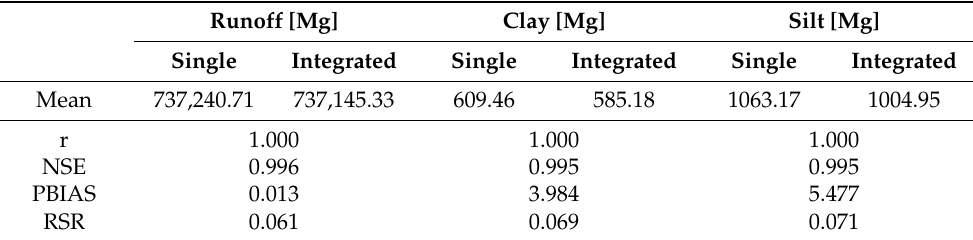
Table 1. Comparison metrics between single and integrated AnnAGNPS ITEAMS simulations at daily time scale of loads at the watershed outlet. Single simulation results were considered reference.